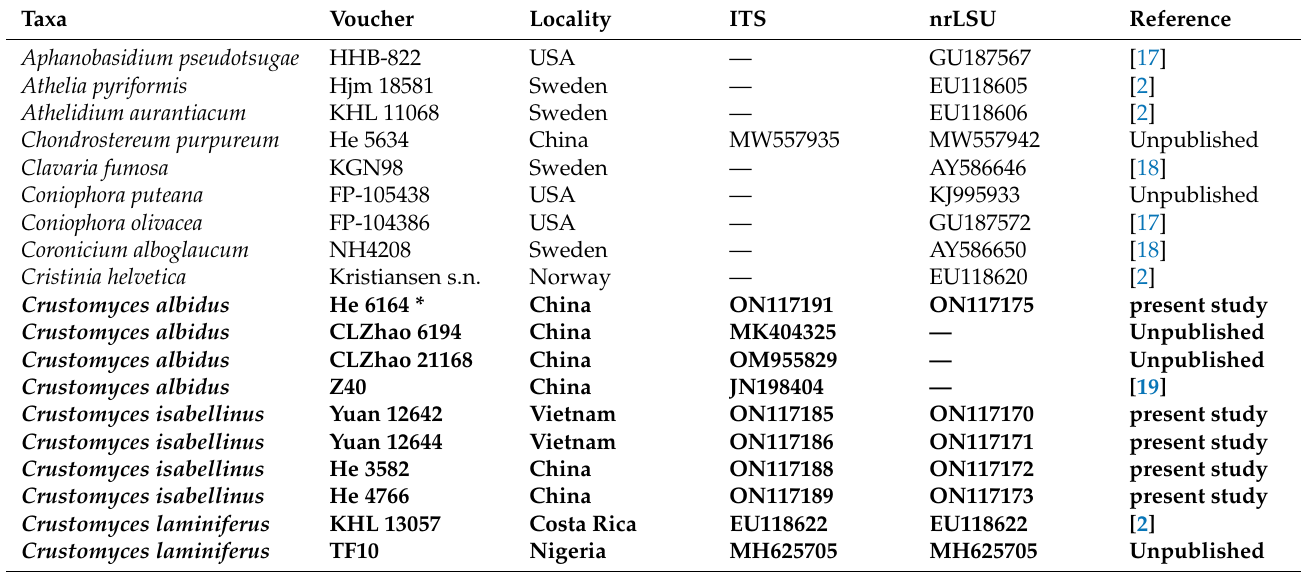
Table 1. Species and sequences used in the phylogenetic analyses. New species and combinations are set in bold with type specimens indicated with an asterisk